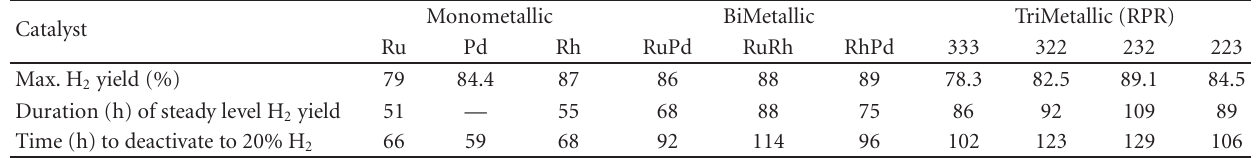
Table 2: Performance summary of the mono-, bi-, and tri-metal supported catalysts.